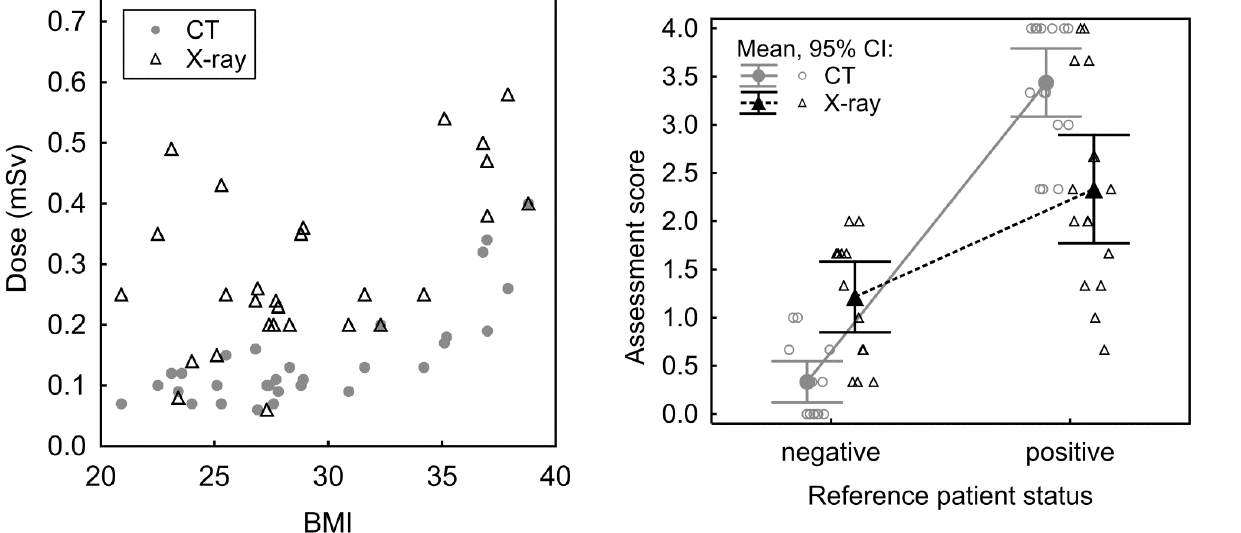
Fig. 3. The assessment score for positive and negative patients in CT and X-ray. TFULDCT showed better ability to discrimi- nate between positive and negative